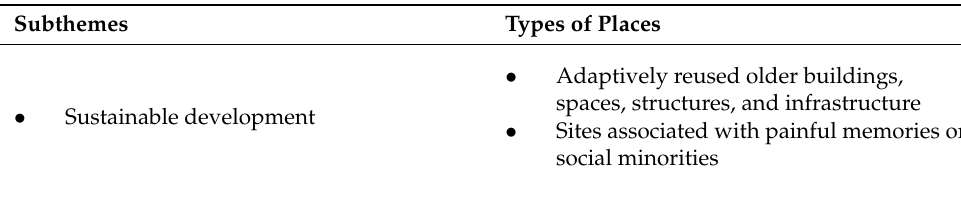
Table 4. Conserving the Natural Environment, Buildings, and